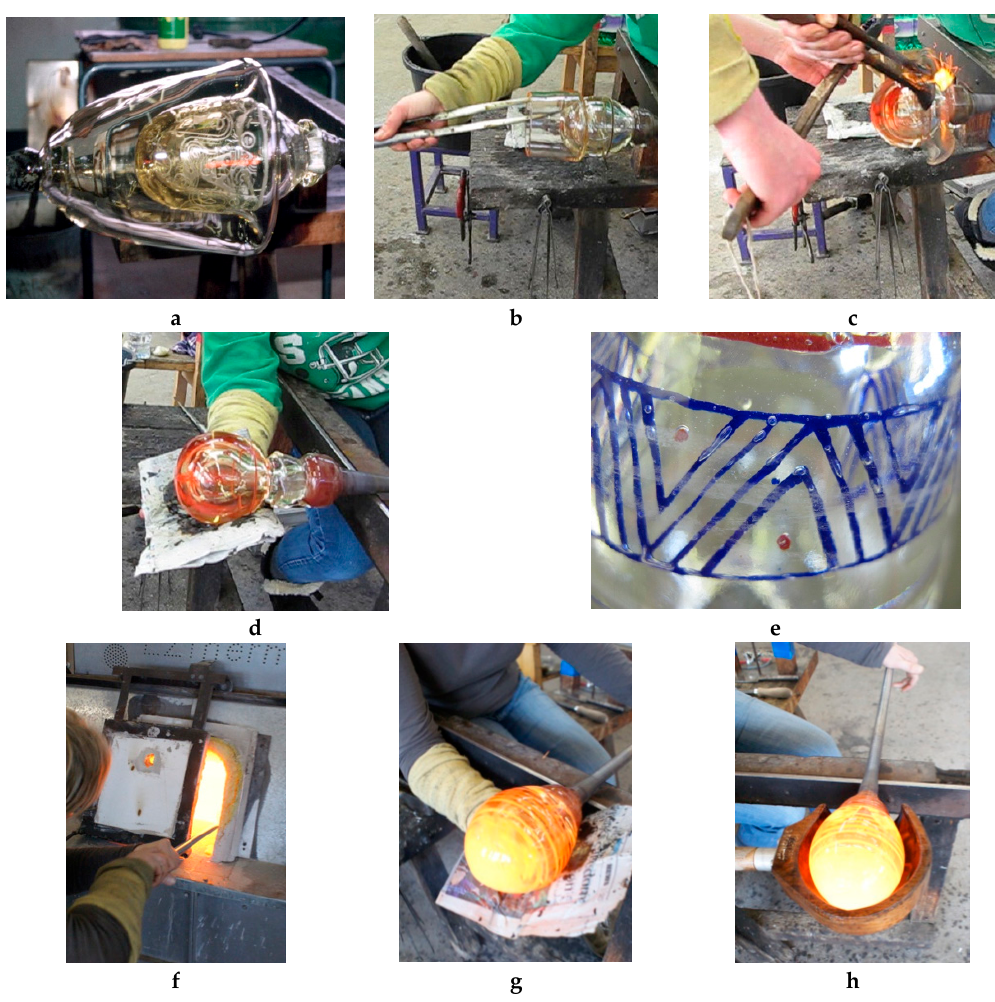
Figure 12. ( a ) Encapsulating a void with a transparent parison pushed over. Photographic source from Ray Flavell’s PhD thesis (2001) (Flavell 2001, p. 60). Used by permission. ( b – e ) Applying a layer of glass with a transparent glass overlay. ( f – h ) Gathering the second layer of glass from the furnace and shape the glass with glassblowing tools.